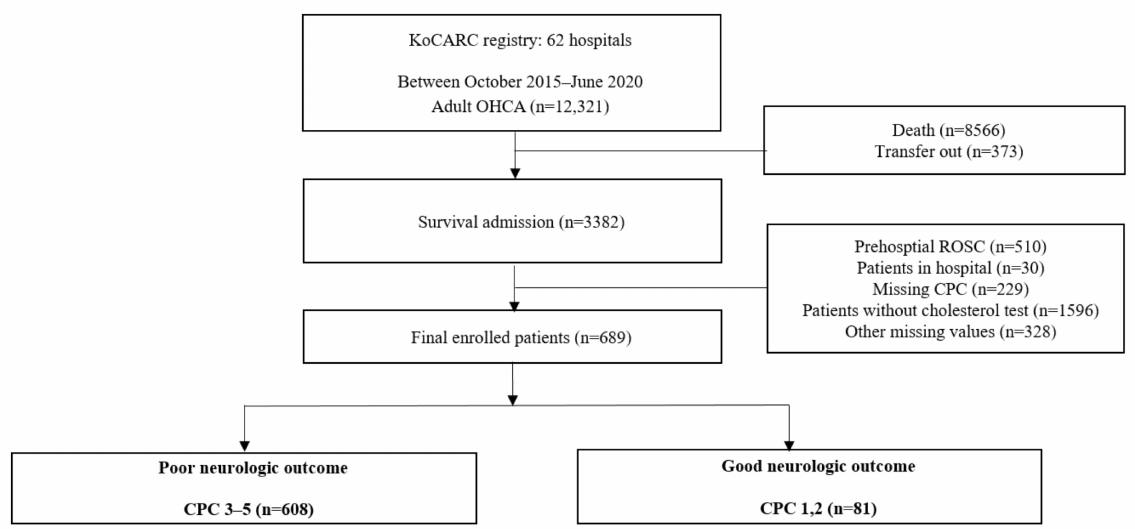
Figure 1. Flow chart of the study (KoCARC, Korean Cardiac Arrest Resuscitation Consortium; OHCA, out- of-hospital cardiac arrest; ROSC, Return of spontaneous circulation; CPC, Cerebral Performance Category).